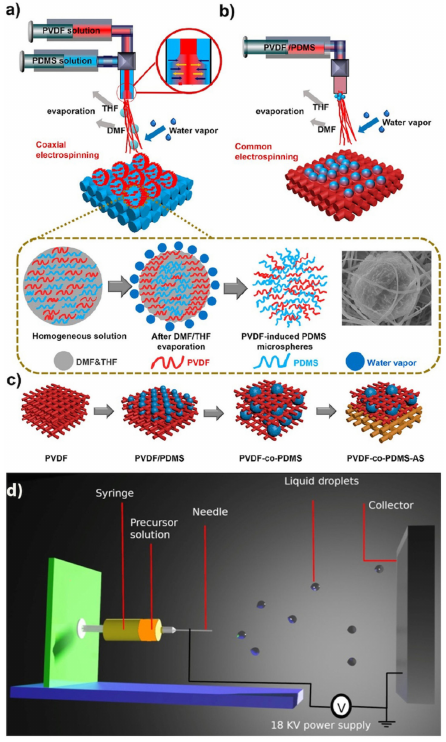
Figure 20. Schematic representation of ( a ) the coaxial and ( b ) conventional electrospinning process for the fabrication of nanofiber membrane, ( c ) fabrication steps of the asymmetric PVDF-co-PDMS nanofiber membranes (PVDF-co-PDMS-AS). The red nanofibers, blue microspheres, and brown sub- strate represent the PVDF selective layer, PDMS-based nanoparticles, and PVDF substrate, respectively. (Reprinted with permission from [129]. Copyright {2021} American Chemical Society). ( d ) A schematic of an electrospraying process. (Reproduced from [130] with permission from John Wiley and